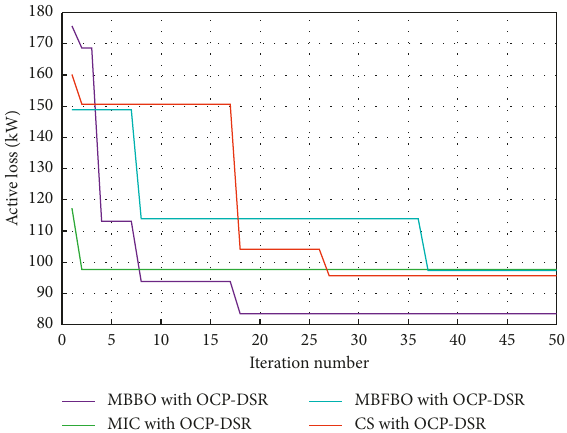
Figure 6: Convergence loss graph for 33-bus RDS using OCP-DSR technique. Table 10: Results and comparisons of IEEE 69-bus RDS without and with individual OCP technique.